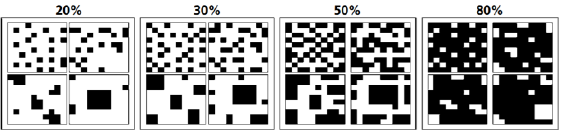
Figure 4: Visual guide for assessing plant cover (Hines et al., 2010). The percentage coverage of plant matter is used to estimate FL.